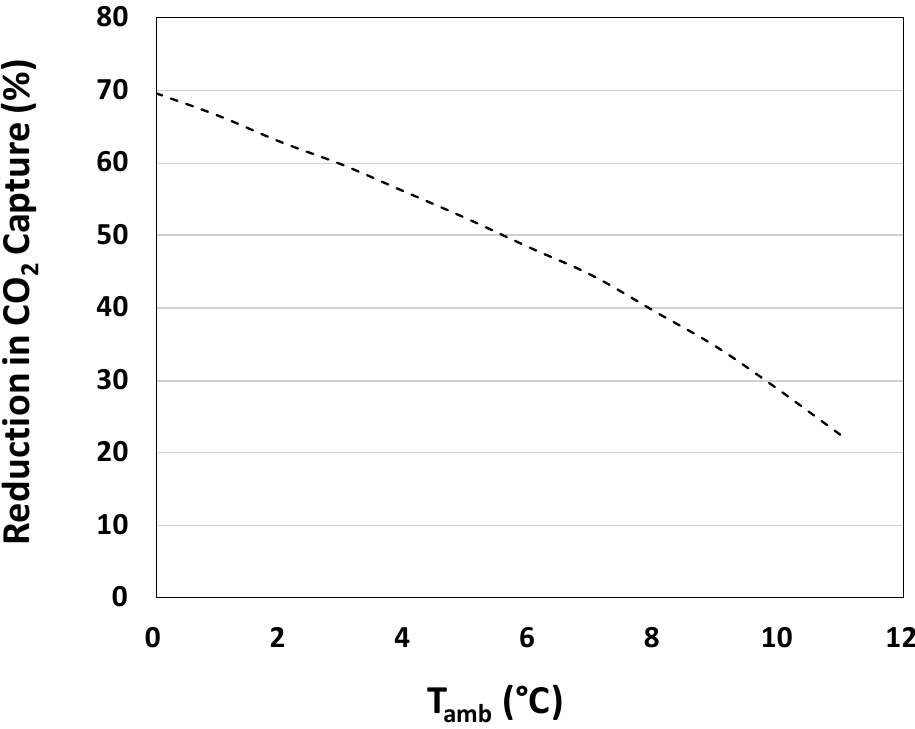
Figure 11. Reduction in overall CO 2 capture vs. ambient temperature for a photobioreactor with operating heat integration equipment. Reduction in CO 2 capture values are instantaneous energy penalties associated with the operation of heat integration equipment and calculated using the overall heat transfer coefficient derived from the data-based model.